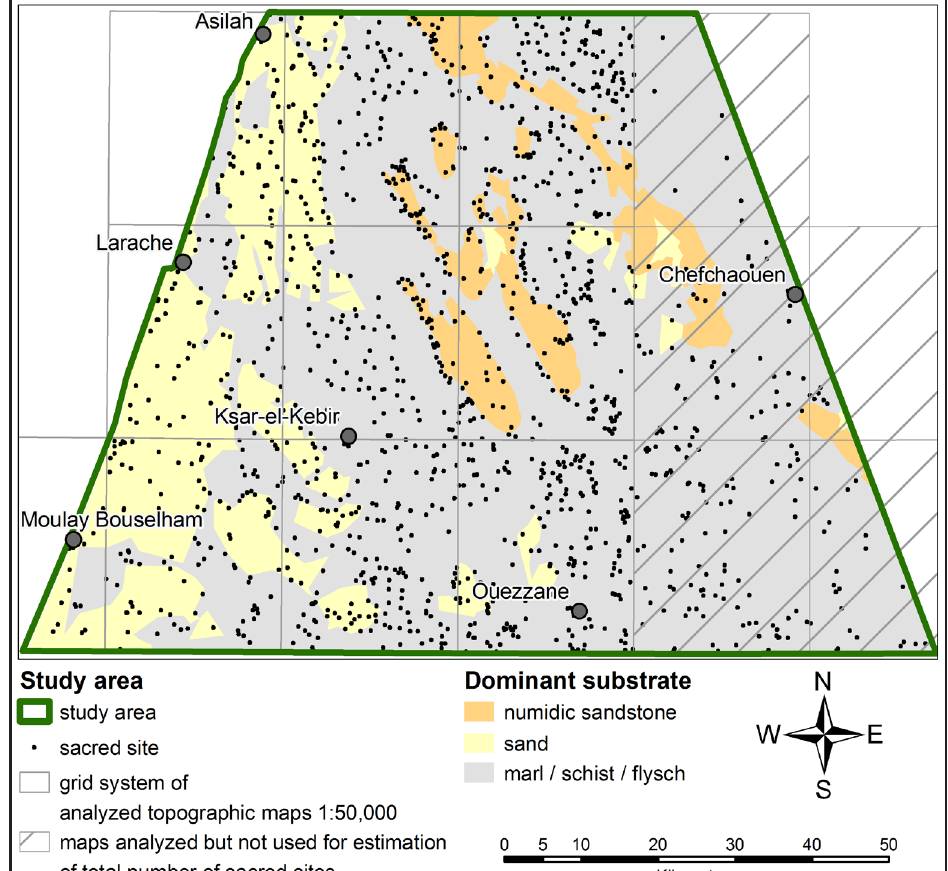
Figure 5: Distribution of SaS in the study area (dominant substrate as background information taken from Ministère de l´Energie et des Mînes